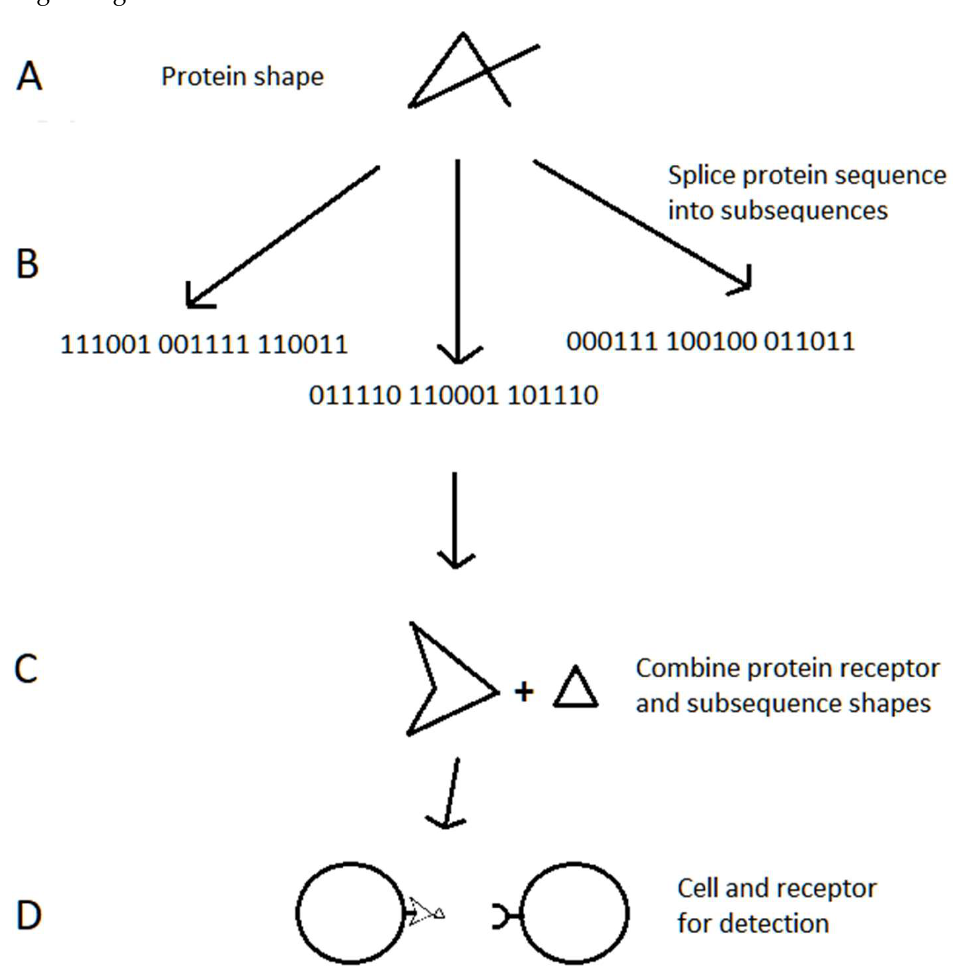
Figure 5. One simplified pathway of jawed vertebrate immunity—from intracellular pathogenic protein to its detection by a host cell. ( A ) Shape of viral protein in three dimensions; ( B ) protein is spliced into protein subsequences; ( C ) subsequence of viral protein is combined with a host cell receptor; ( D ) the protein subsequence and receptor from ( C ) are bound to the surface of a host cell (on the left). A specific immune cell (on the right) with a cell-surface receptor scans the host cell for evidence of pathogenic protein subsequences. Positive detection of a pathogenic protein may contribute to an immune response, so that host cells infected with a pathogen are eliminated by the immune system.